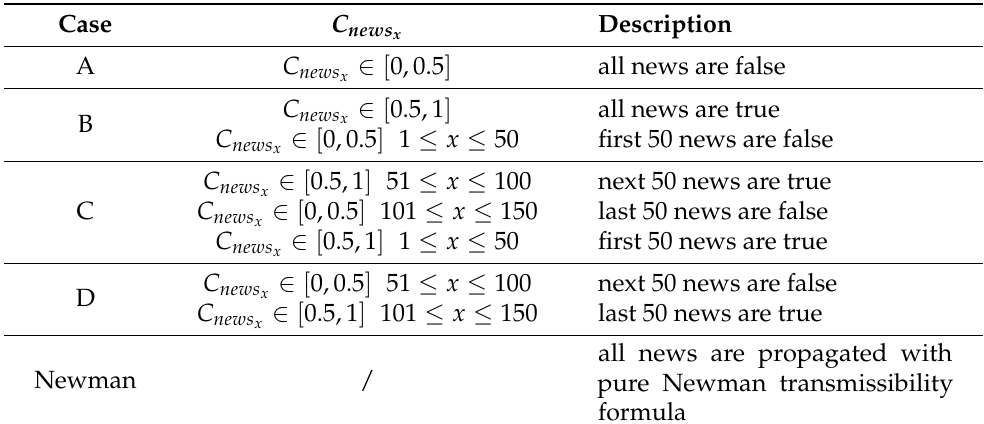
Table 1. Simulation scenarios.